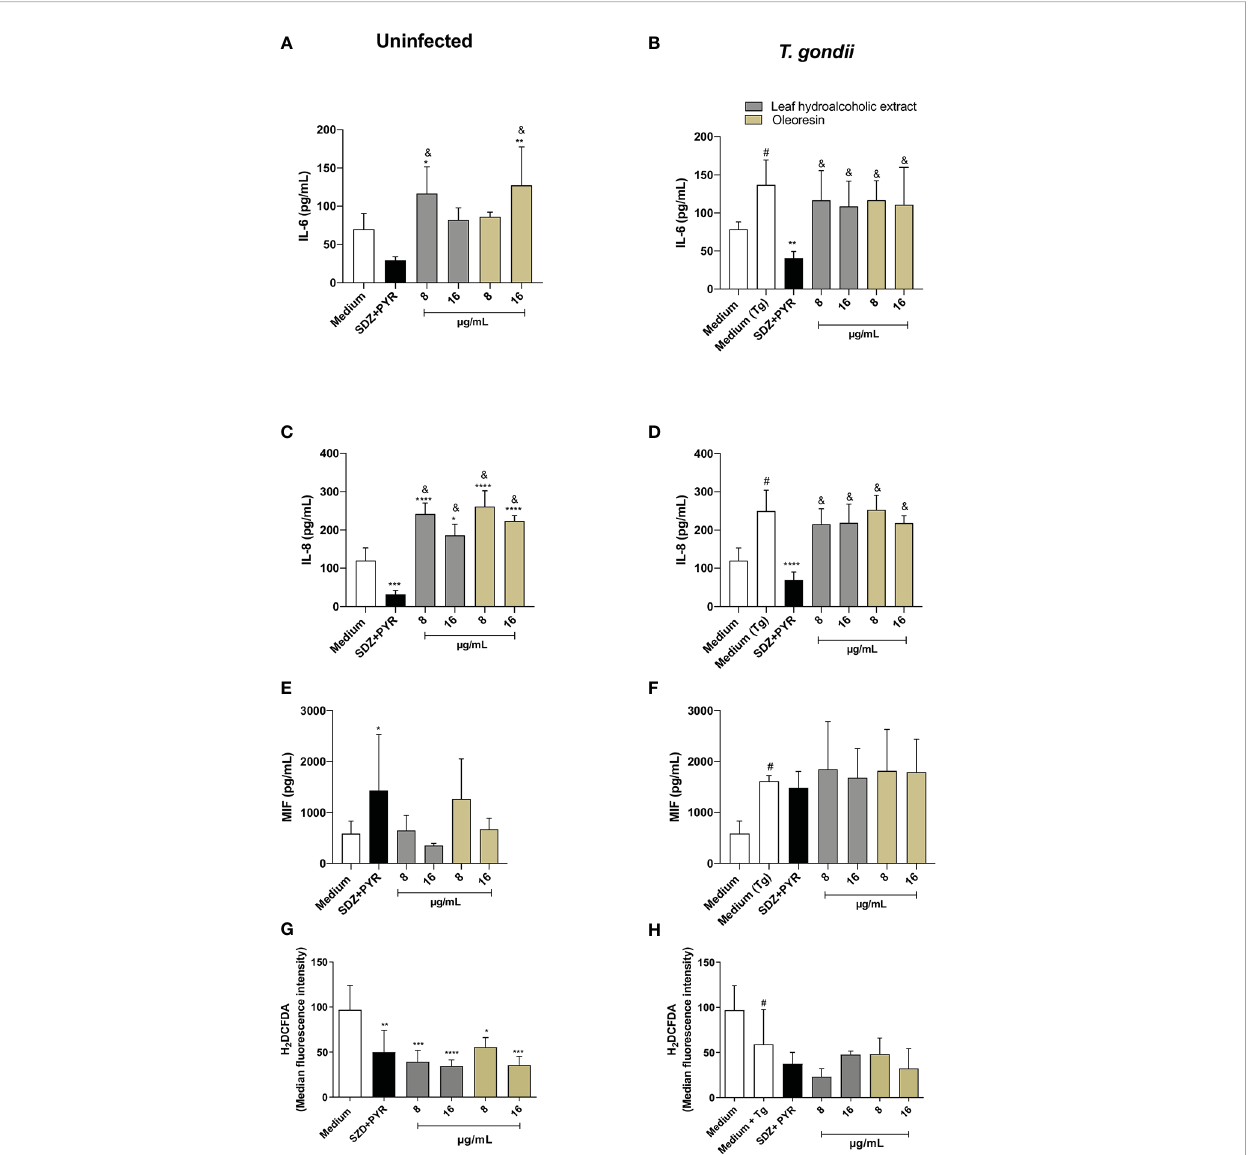
FIGURE 8 Cytokine and ROS production in HTR8/SVneo cells. HTR8/SVneo cells were infected and treated or not with the hydroalcoholic extract or oleoresin from C. multijuga for 24 h. Untreated and uninfected cells (medium), untreated and infected cells (medium Tg) and SDZ + PYR were used as controls. Then, supernatants were collected and used to measure IL-6 (A, B) , IL-8 (C, D) and MIF (E, F) . In parallel, HTR8/SVneo cells were infected, treated or not with the hydroalcoholic extract or oleoresin from C. multijuga for 24 h, incubated with the probe 2 ′ ,7 ′ -dichlorodihydro fl uorescein diacetate (H2DCF-DA), ROS production was measured by a plate reader and data were expressed as mean fl uorescence intensity (MFI) (G, H) . The results were expressed as means ± standard deviation of three experiments performed in eight replicates. Signi fi cant differences detected by One-Way ANOVA, Bonferroni ’ s multiple comparisons post-test. * P < 0.01, ** P < 0.001, *** P < 0.0001 or **** P < 0.00001 in relation to the medium (for uninfected cells) or to the medium Tg (for infected cells). & P < 0.05 in relation to SDZ + PYR (for uninfected or infected cells). # P < 0.05 between medium and medium